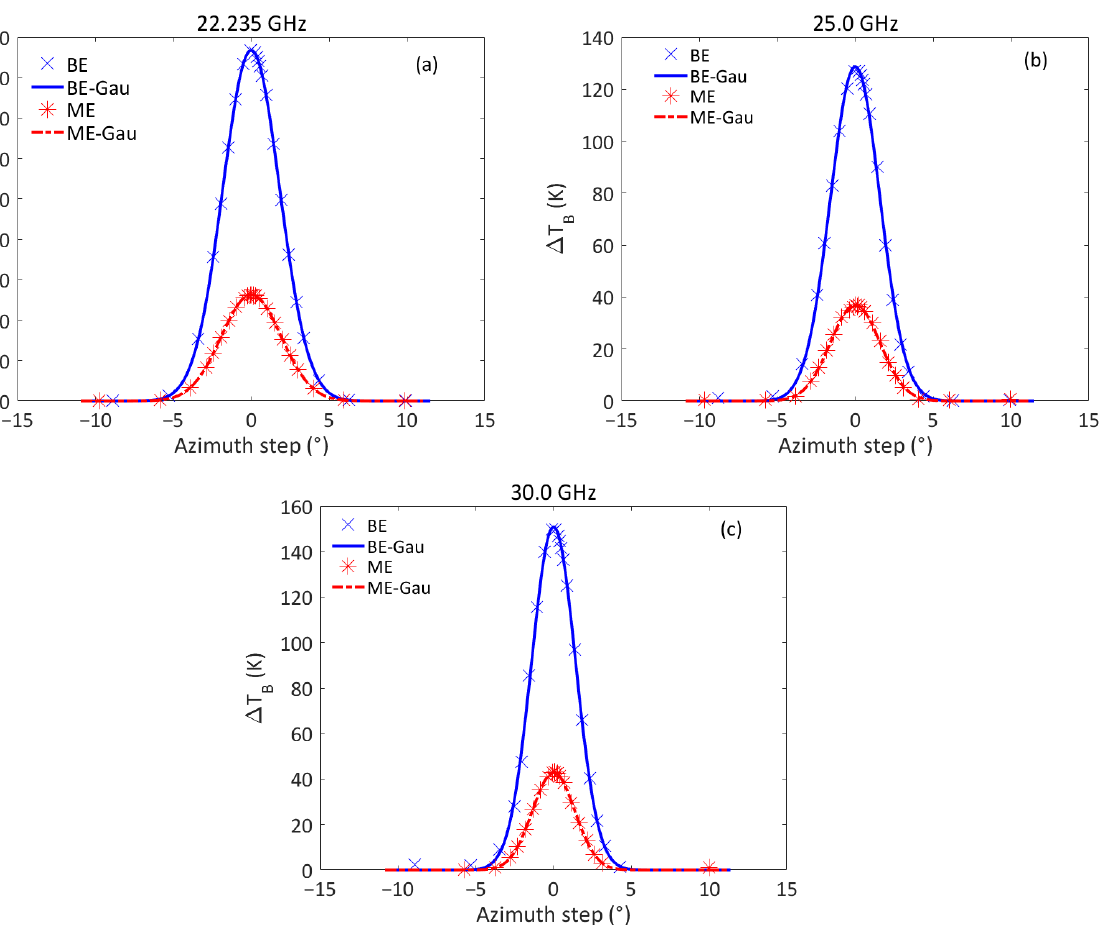
Figure 5. The variation of T B increment during the scanning of the sun at the azimuth on 21 Jun 2020. BE means “before eclipse” and ME means “maximum eclipse”. The dots are observed data and the line is a fitting of the Gaussian function (Gau). ( a ) 22.235 GHz, ( b ) 25.0 GHz, ( c ) 30.0 GHz. Table 4. The parameters obtained by curve fitting with the Gaussian function at each of the three frequencies. BE means “before eclipse” and ME means “maximum eclipse”.